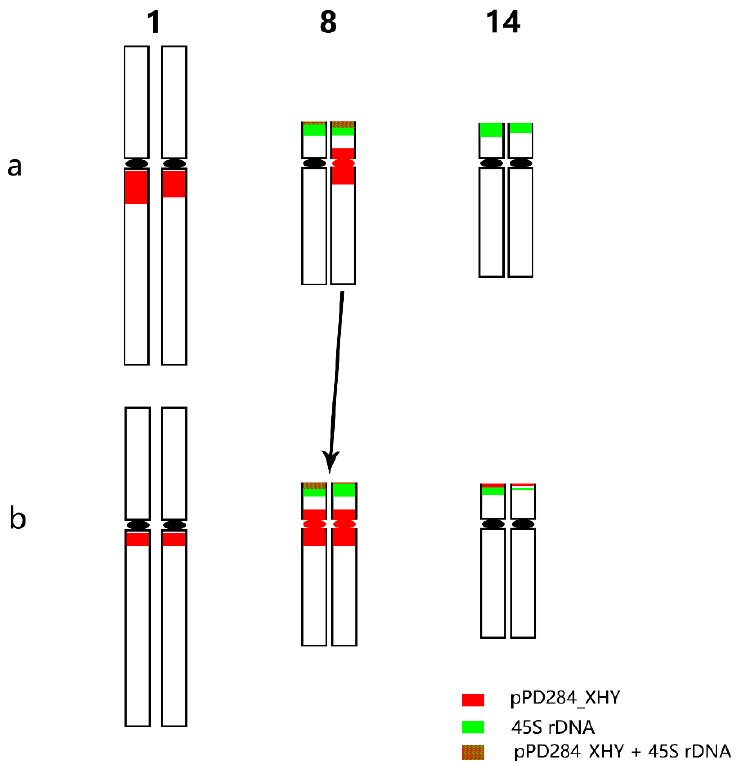
Figure 5. Predicted FISH pattern differences between P. xiaohei ( a ) and the derived doubled haploid ( b ). loid ( b